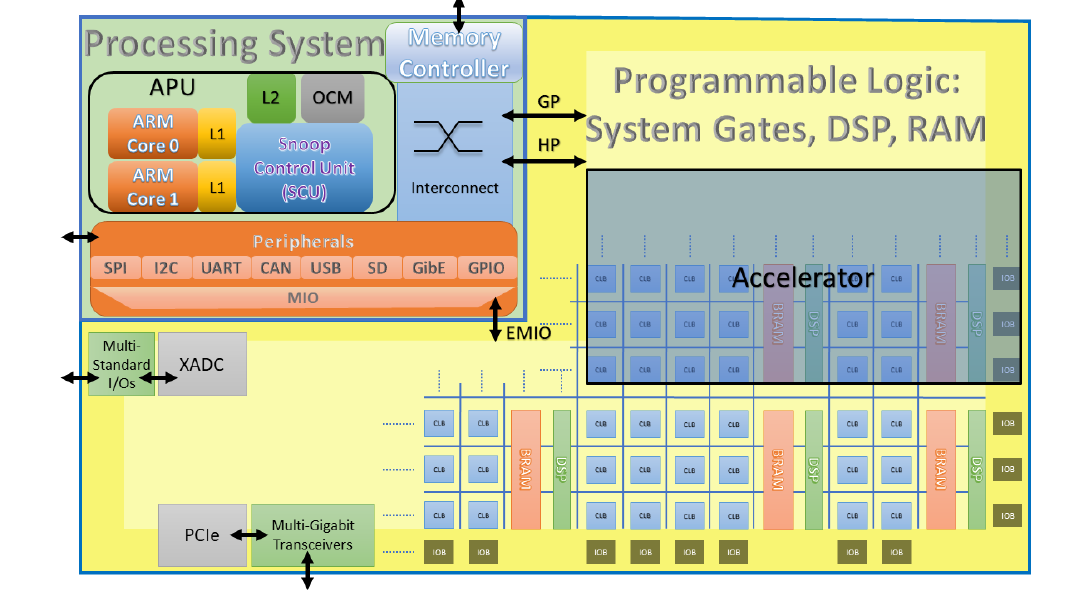
Figure 3. Components of the main processing